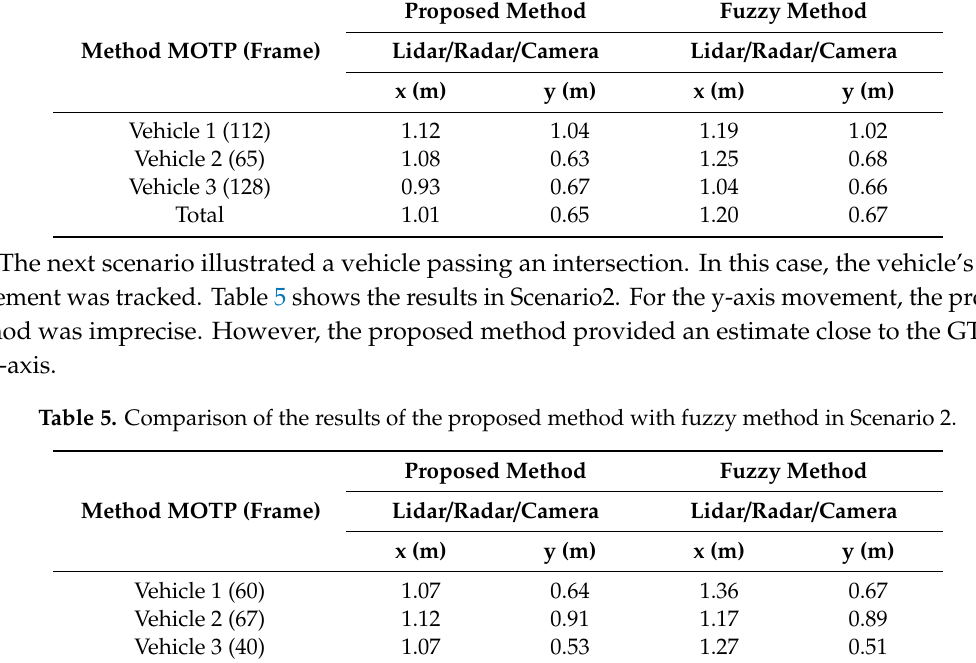
Method MOTP (Frame)